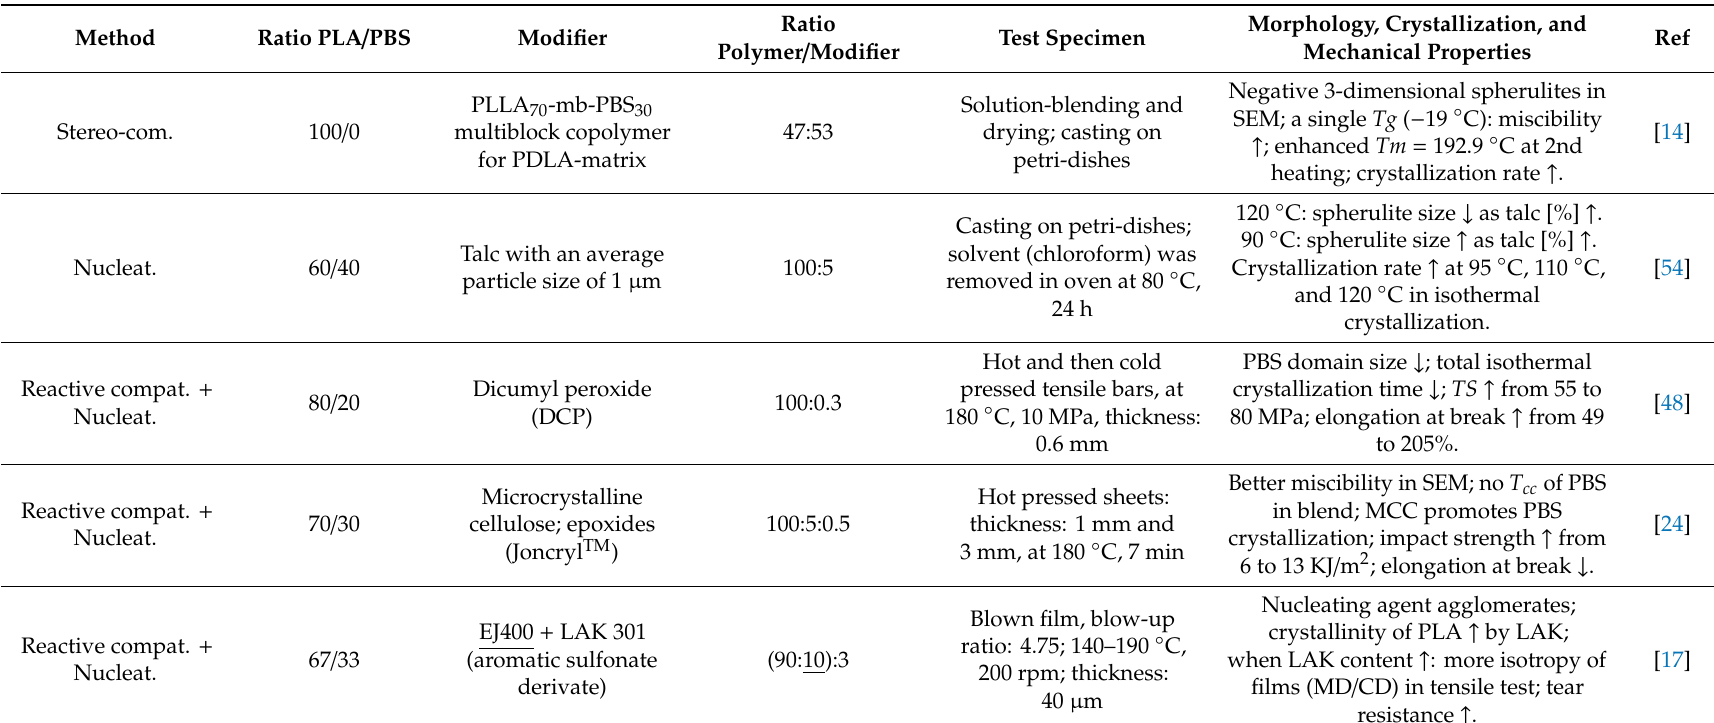
Table 3. Crystallization